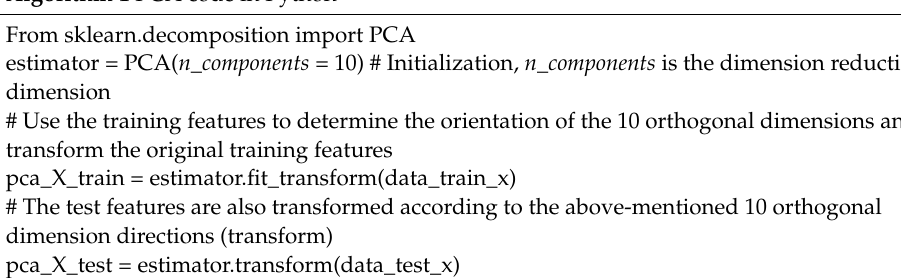
Algorithm 1 PCA code in